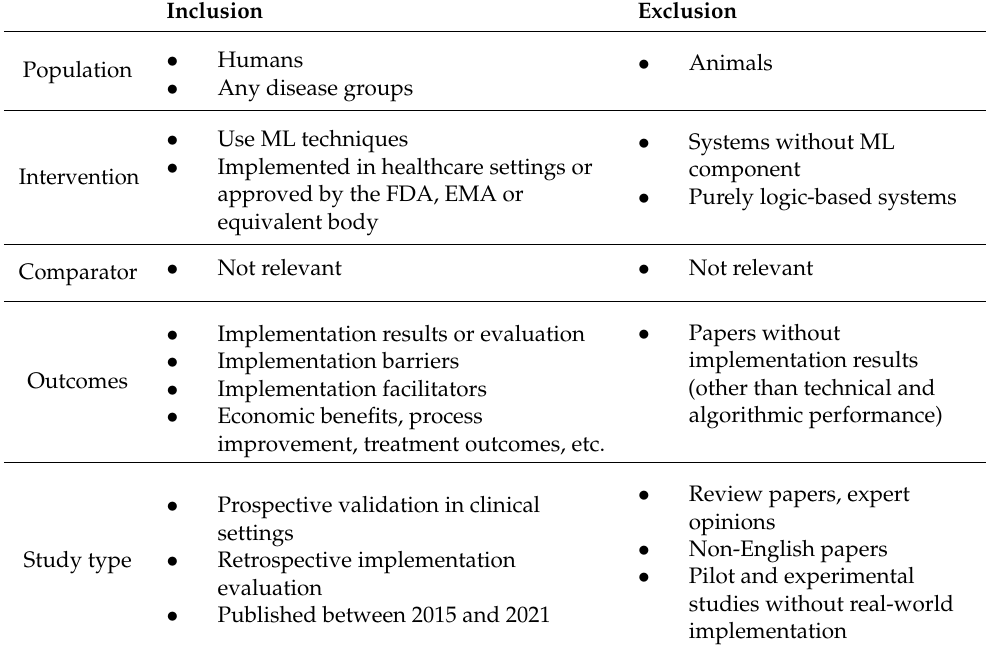
Table 1. Study eligibility criteria based on